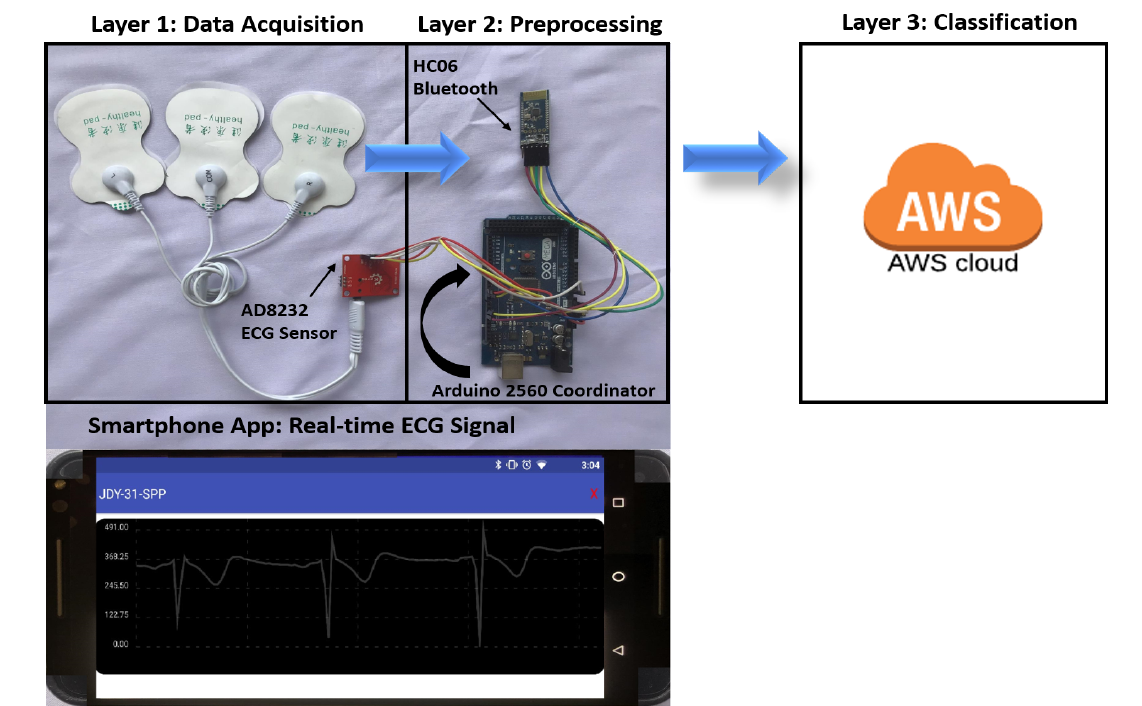
Figure 16. Real-time ECG signal analysis and